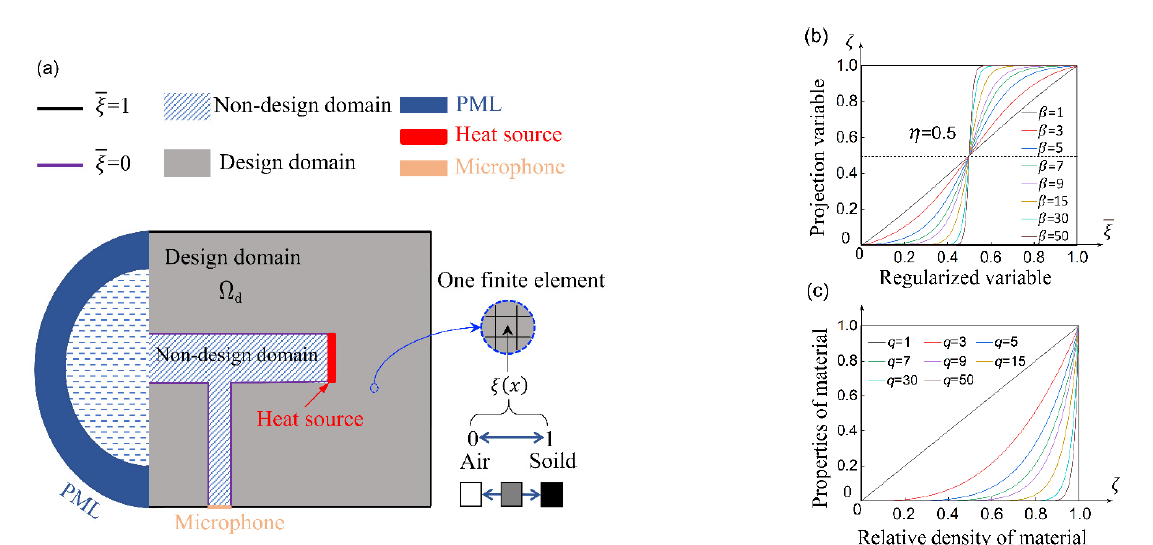
Figure 1. ( a ) Schematic of finite element topology modeling for a T-type opened PA cell. ( b ) Effect of modified Heaviside function with different values of parameter β at η = 0.5. ( c ) Penalization intensity corresponding to different values of penalty factor q